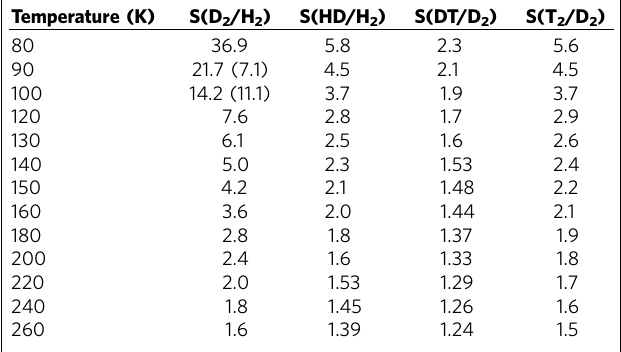
Table 2 | Predicted selectivity of hydrogen isotopologues (thermodynamic equilibrium) at the Cu(I) sites as a function of